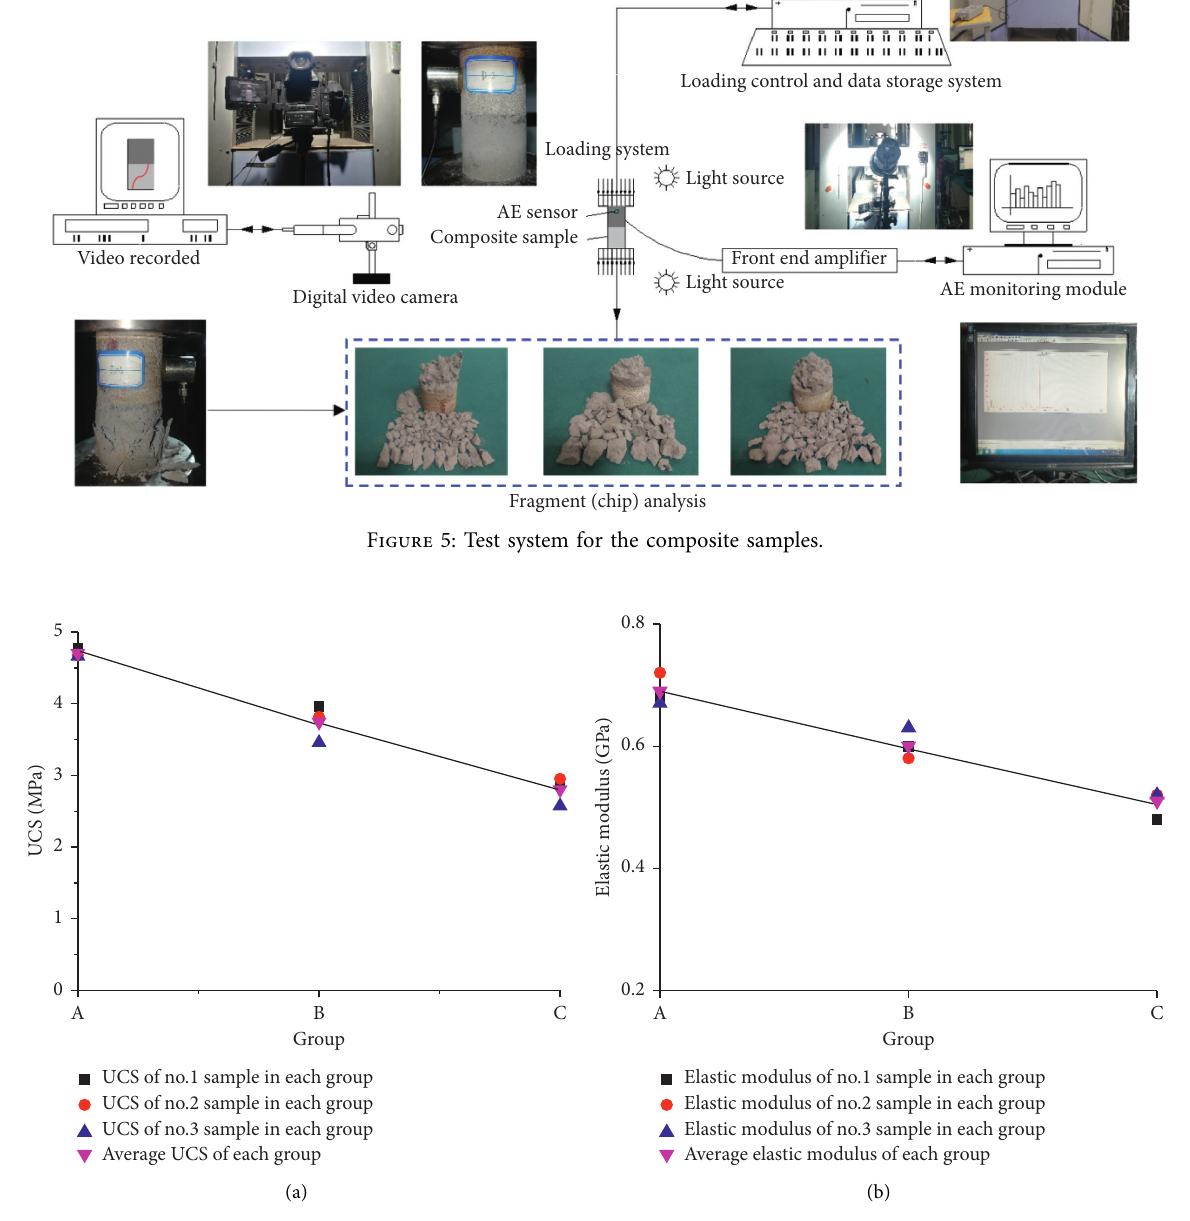
Figure 6: Variations in (a) UCS and (b) elastic modulus of composite samples with coal gangue particle size.